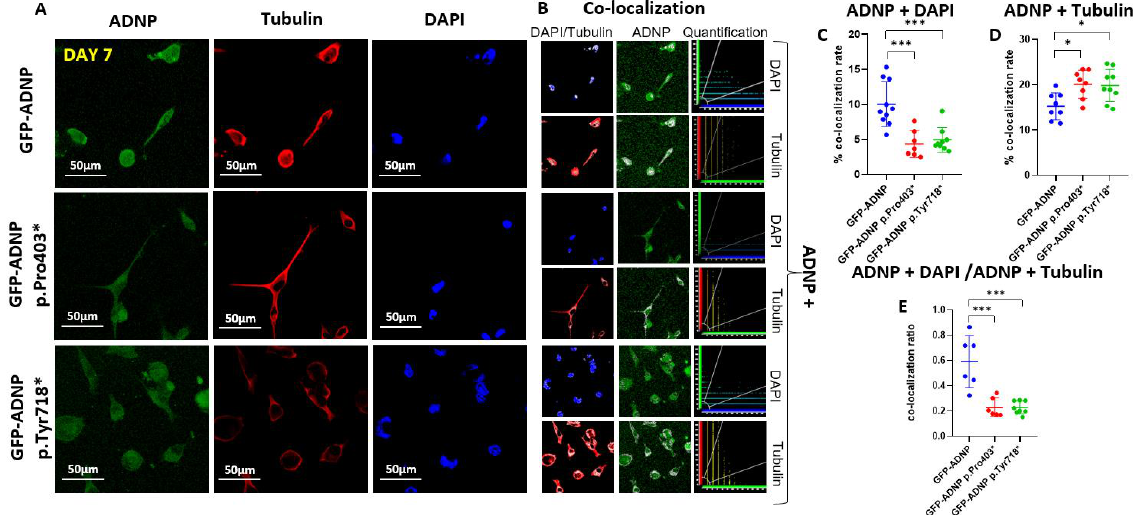
Figure 4. Immunostaining of tubulin and staining with DAPI in differentiated neuroblastoma-like neuronal cells (day 7 in culture) indicated an increased cytoplasmic localization of the ADNP mu-